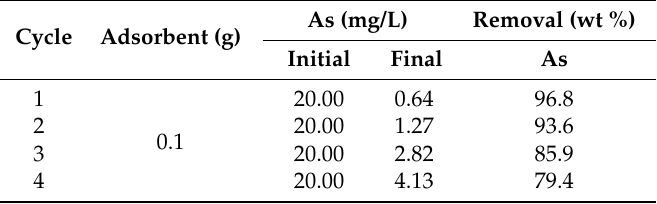
Table 4. As adsorption: cycling and regeneration of the adsorbent.